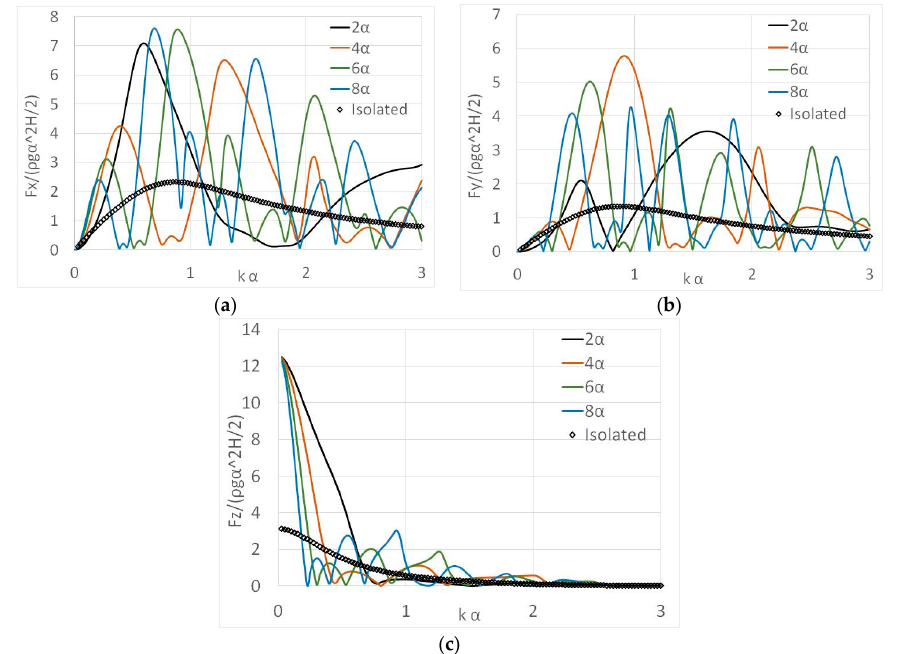
Figure 4. Exciting forces on a floating cylindrical floater placed in front of an orthogonally shaped (right angle) breakwater using the method of images for L 1 = L 2 = 2 α , 4 α , 6 α , 8 α : ( a ) horizontal-exciting force on x -axis; ( b ) horizontal-exciting force on y -axis; ( c ) vertical-exciting force on z -axis. The results are also compared with the corresponding values of the same isolated floater (i.e., without the presence of the walls).